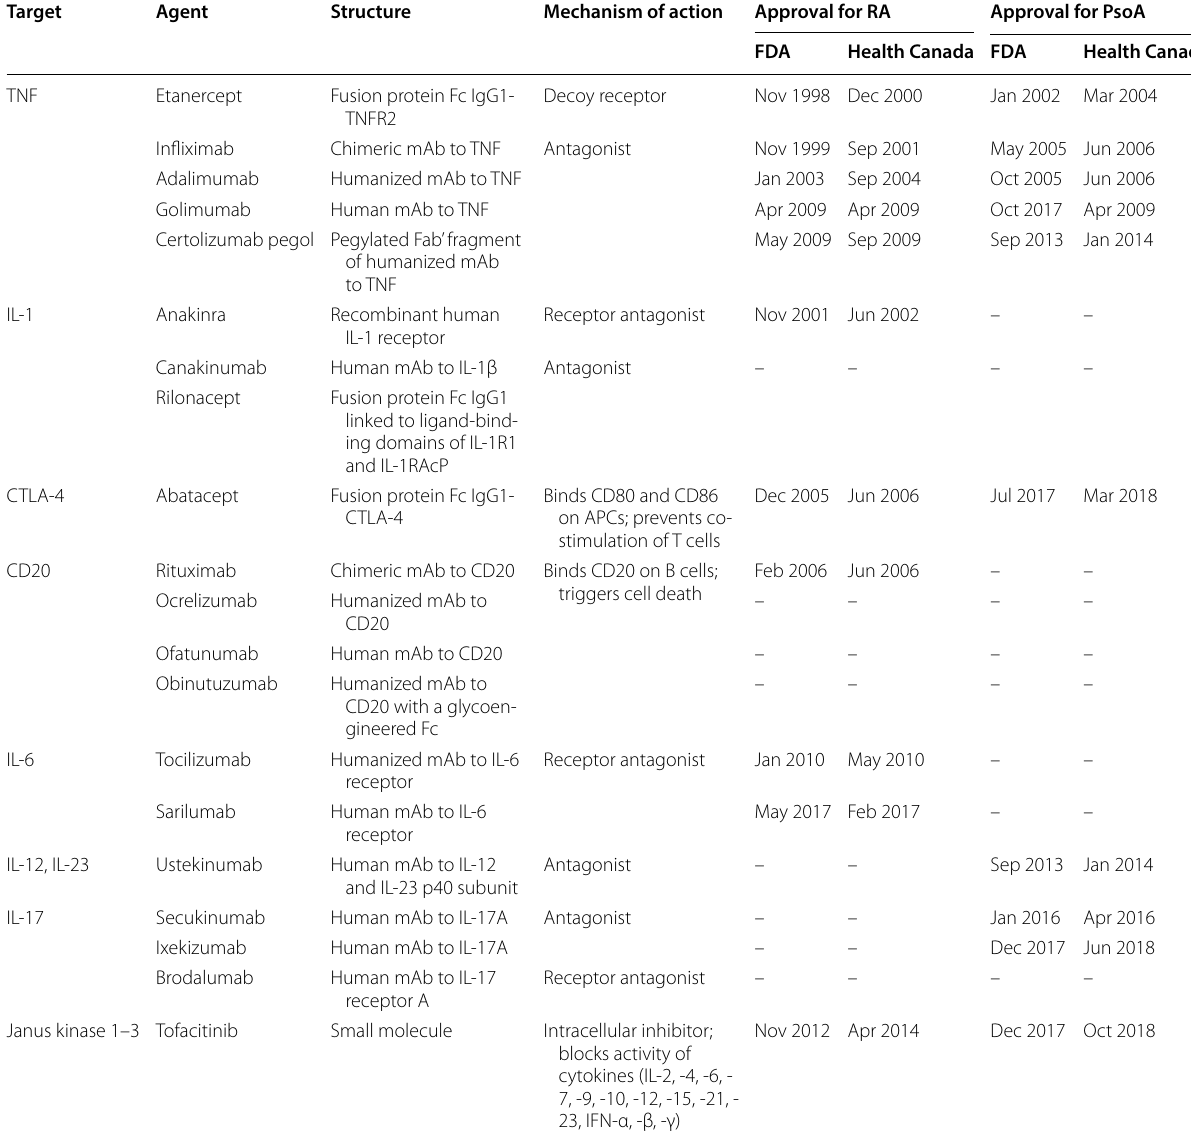
Table 2 Biotherapies and small molecule inhibitors against secreted mediators or immune cells and their approval for rheumatoid arthritis and psoriatic